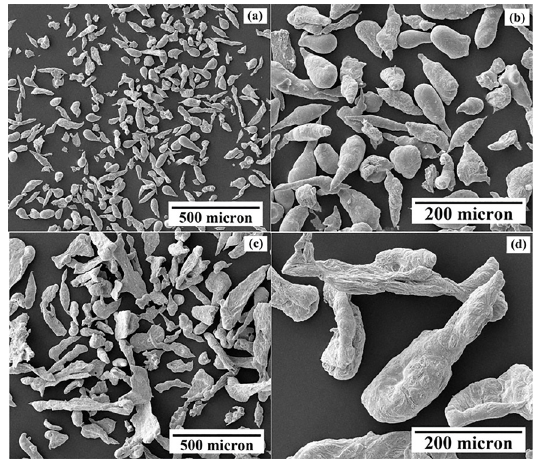
Figure 12. SEM micrographs of zinc powder. (a-b) smaller sizes (25-53 µm) and (c-d) larger sizes (53-212 µm).